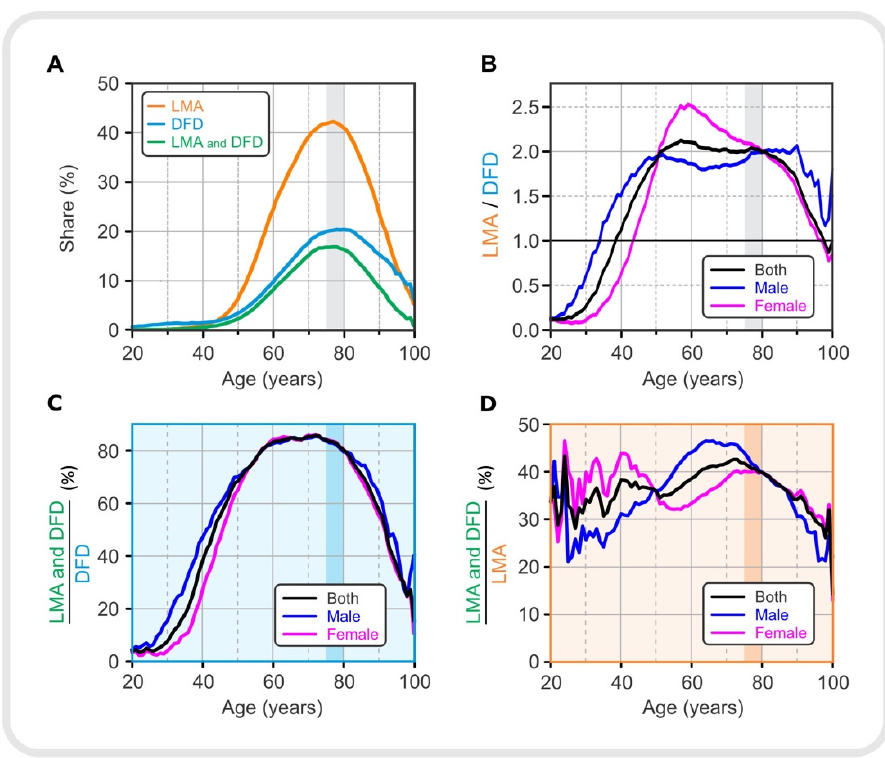
Figure 3. Drug use in different age groups. ( A ) Proportion of lipid-modifying agents, LMA, (orange), drugs for diabetes, DFD, (light blue), LMA, and both LMA and DFD (green). ( B ) The ratio between the proportions of LMA and DFD. ( C ) Proportion of patients taking both types of medication (LMA and DFD) normalized to diabetic patients taking DFD in the same age and sex group. ( D ) Proportion of patients taking both types of medication (LMA and DFD) normalized to patients with lipid dysregulation taking LMA in the same age and sex group. LMA—lipid-modifying agents, DFD—drugs for diabetes.